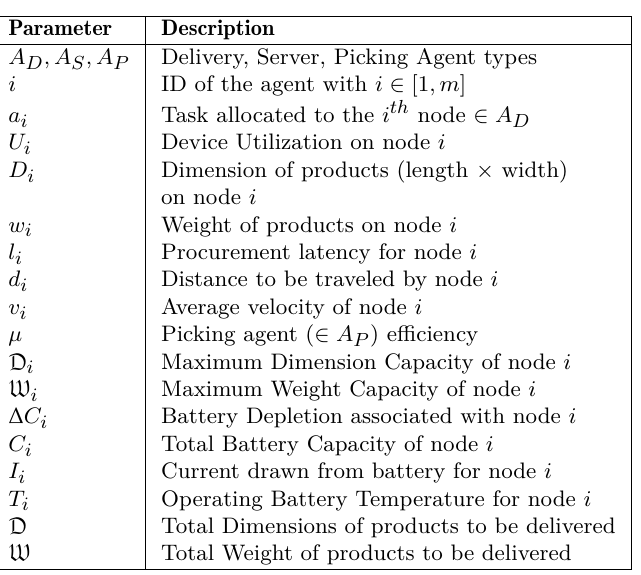
Table 1. Parameters included in Optimization Formula- tion.